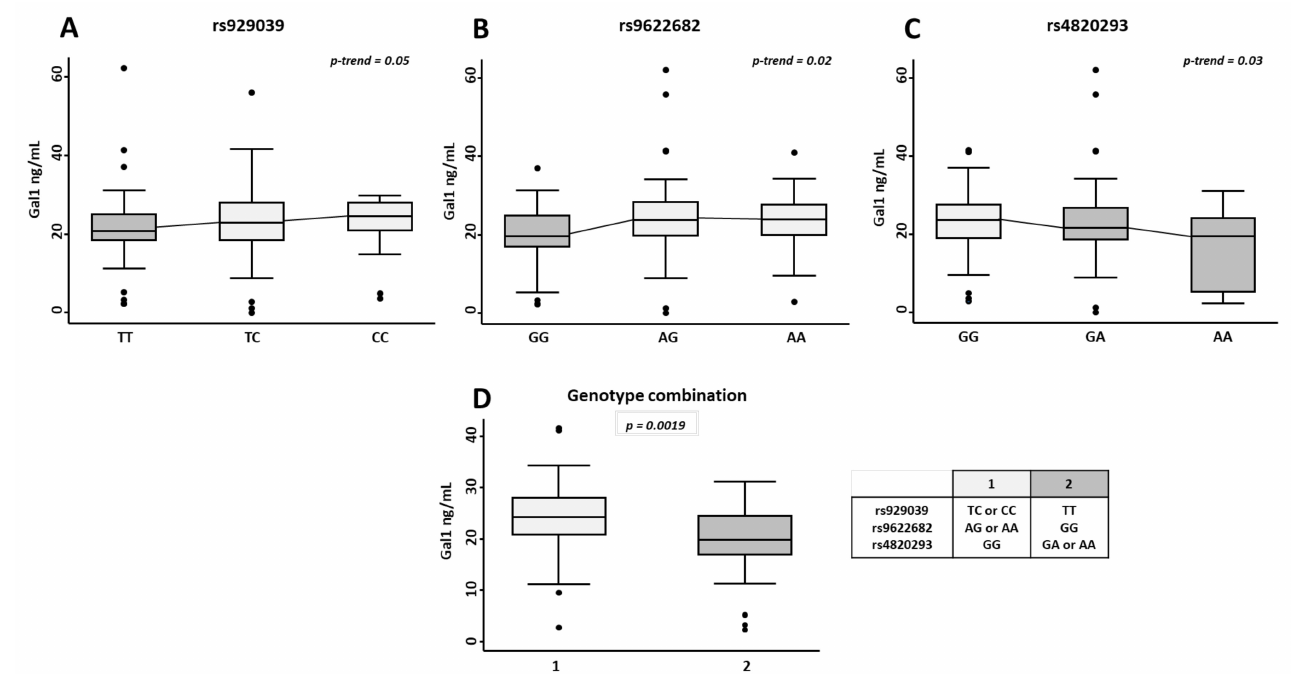
Figure 1. Effect of the LGALS1 genetic variants rs929039, rs9622682, and rs4820293 in galectin 1 (Gal1) serum levels. Determination of Gal1 serum levels by ELISA in early arthritis patients (undifferentiated arthritis and rheumatoid arthritis) from the PEARL study according to the different genotypes for the single nucleotide polymorphisms (SNPs) rs929039 ( A ), rs9622682 ( B ), rs4820293 ( C ) and genotypes combination ( D ). Data are shown as interquartile range (p75 upper edge of box, p25 lower edge, p50 midline) as well as the p95 (line above box) and p5 (line below). Dots represent outliers. Statistical significance for the trend of Gal1 across the different genotype in patients was determined